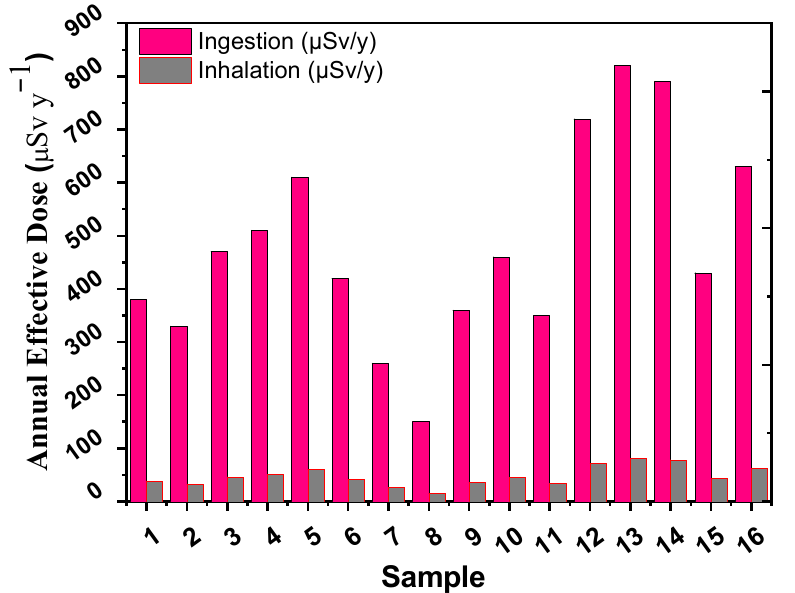
Figure 6. The annual effective dose with ingestion and inhalation for the sixteen water samples.